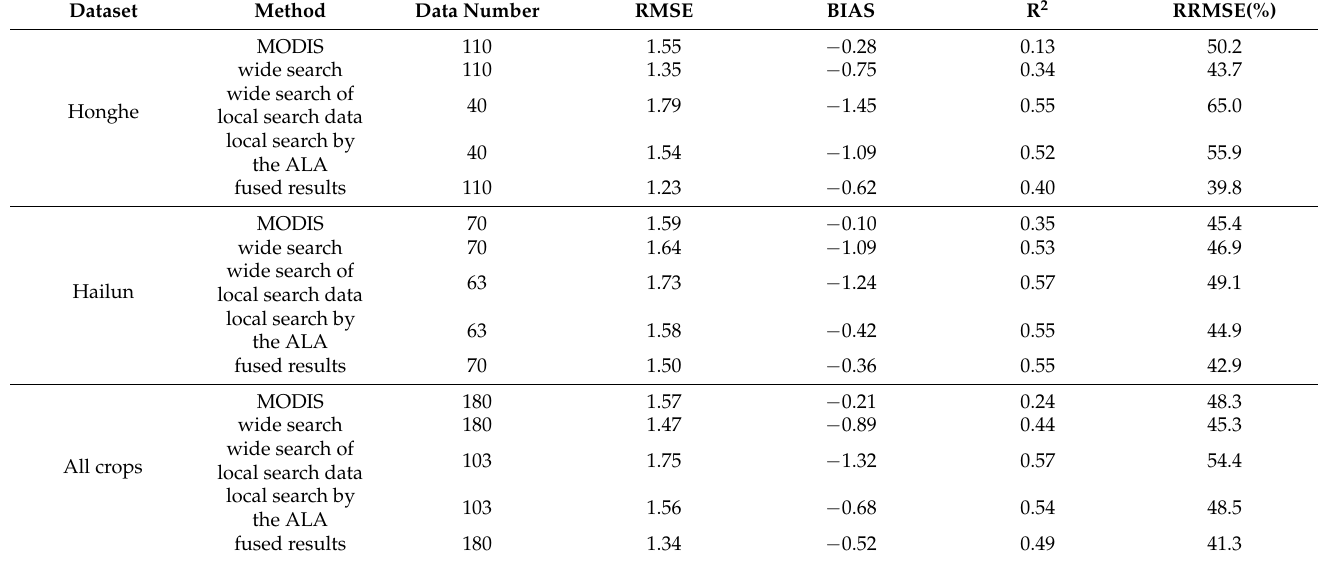
V006 MODIS LAI product (i.e., MCD15A2H), where only data generated by the main